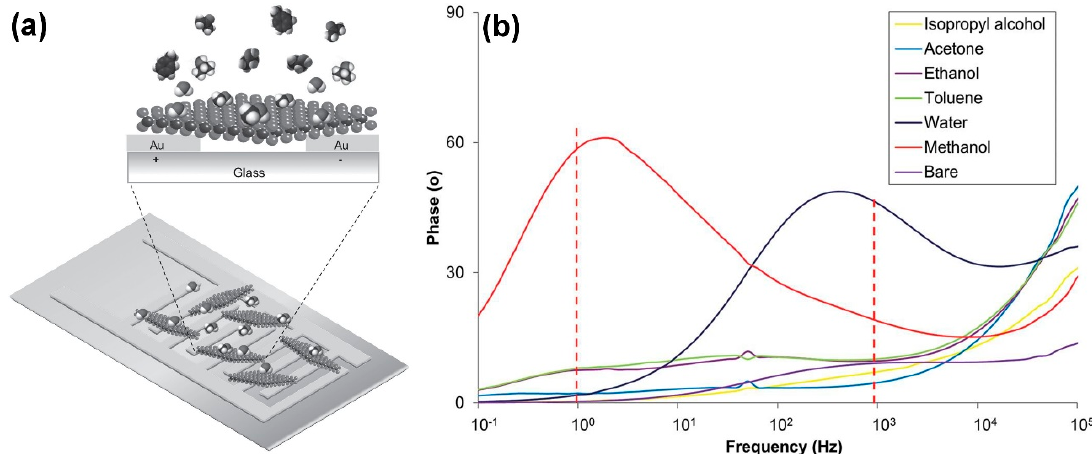
Figure 4. Panel ( a ): schematic of the impedance sensor with a 1T-WS 2 sensing layer; Panel ( b ): selectivity studies of 1T-WS 2 sensor, impedance phase spectra (adapted with permission from [45].